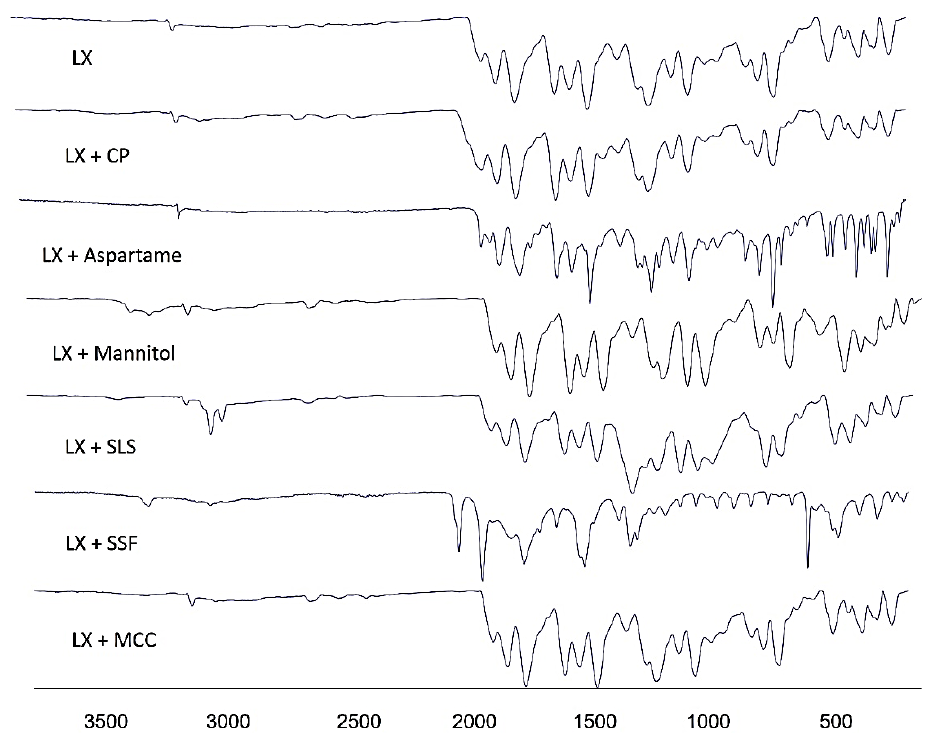
Figure 3. FTIR spectra of pure LX; LX + CP; LX + Manitol; LX + MCC; LX + SLS; LX + Aspartame; and LX + SSF.